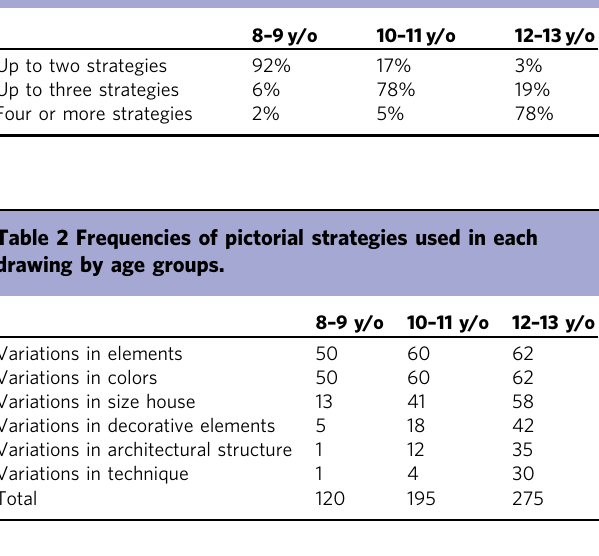
Table 1 Percentages of quantitative levels of pictorial strategies used by children by age groups.